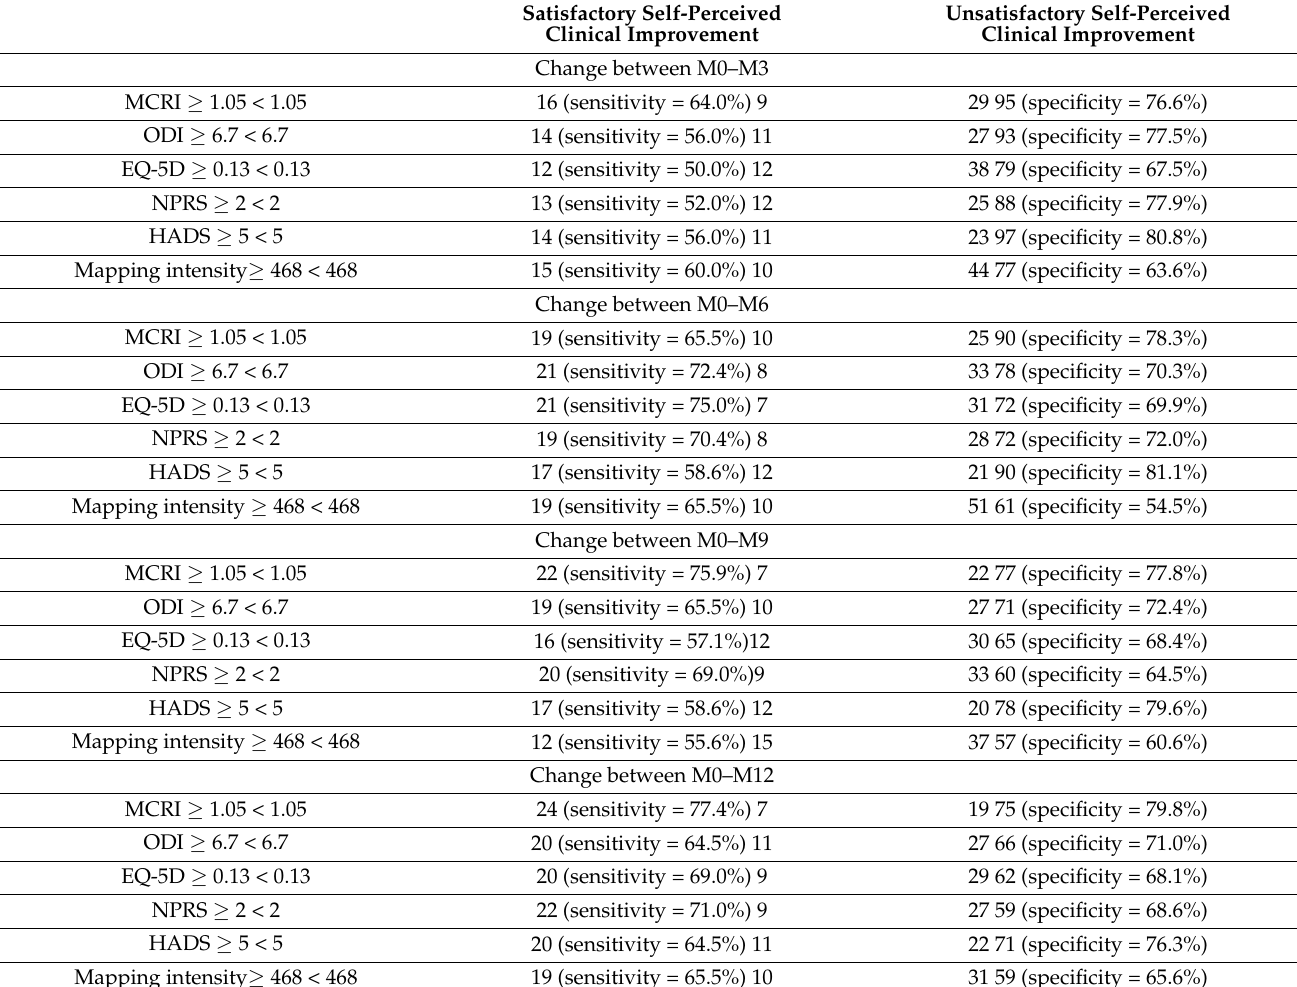
Table 7. The specificity and sensitivity of MCRI, ODI, EQ-5D, NPRS, HADS and mapping intensity at detecting patient satisfaction with their perceived change at each visit. To allow comparability, cutoffs maximizing specificity and sensitivity were identified for each